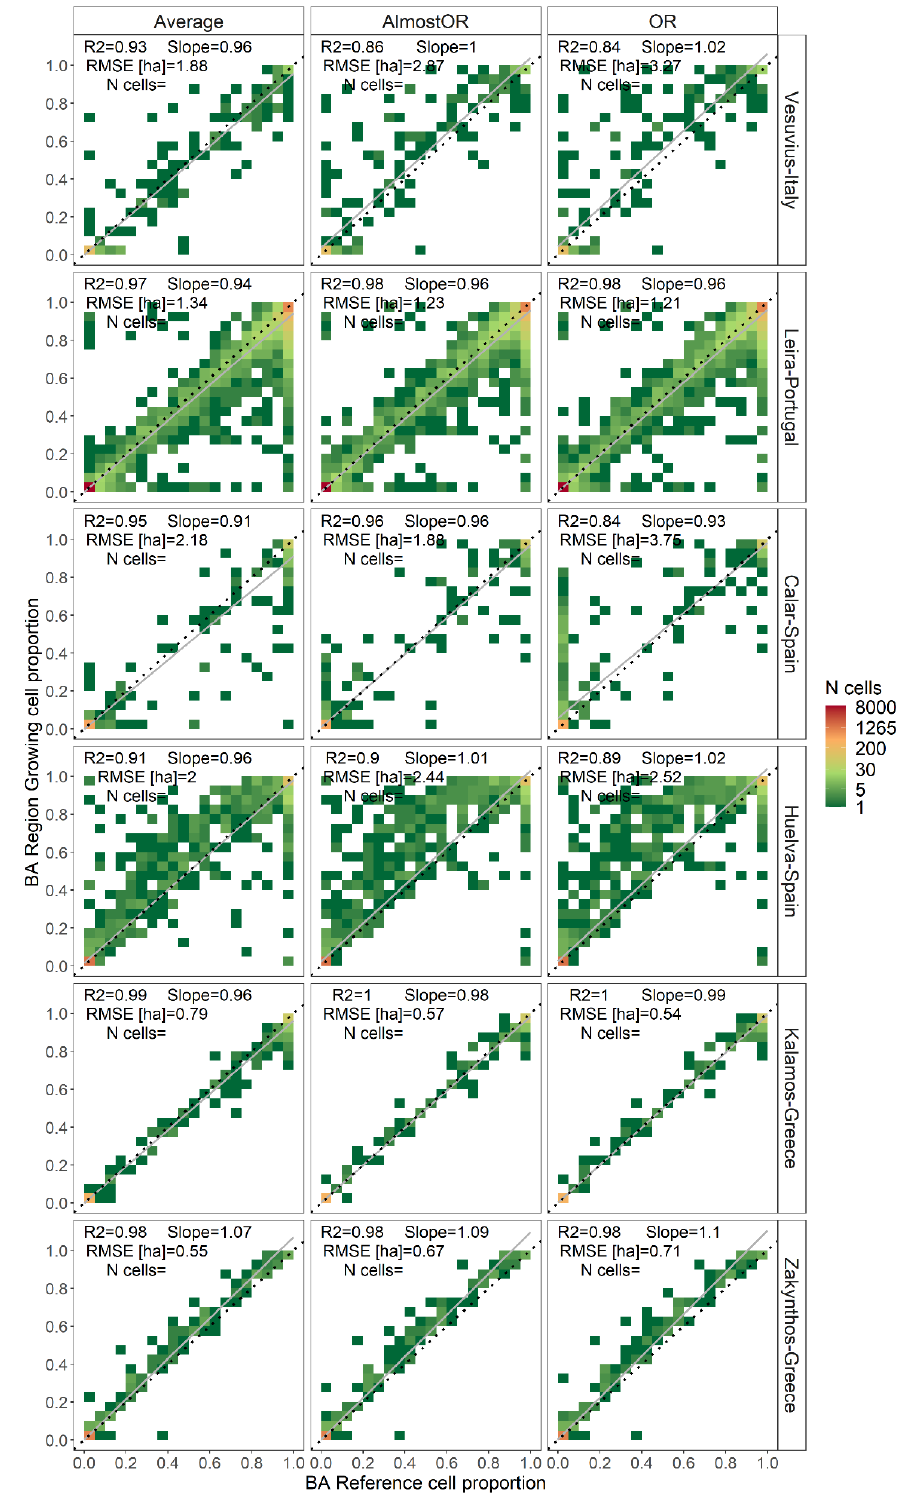
Figure 11. Scatter plot of the proportion of 500 m × 500 m grid cell mapped as burned in the RG output and the reference dataset for each site and OWA grow layer. Scatter plots are displayed as counts of cells for 0.05 step along the x- and y -axis to better represent overlapping points and with a logarithmic color scale. The black dotted line is the 1:1 line while the gray continuous line is the linear regression model. The coefficient of determination (R2), slope of the regression linear model (Slope), root mean squared error (RMSE) and total number of cells (N cells) are also